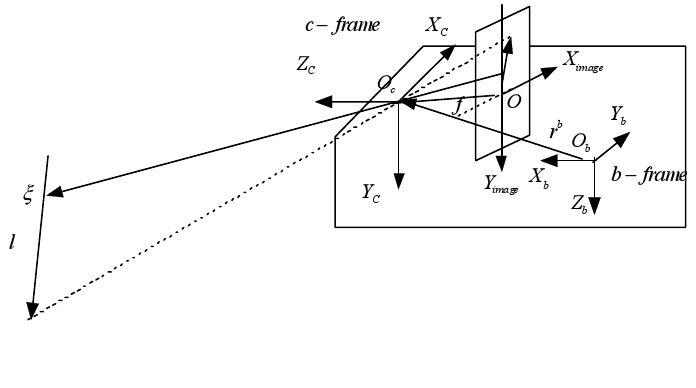
Figure 1. Geometry of visual/inertial/magnetic sensor based